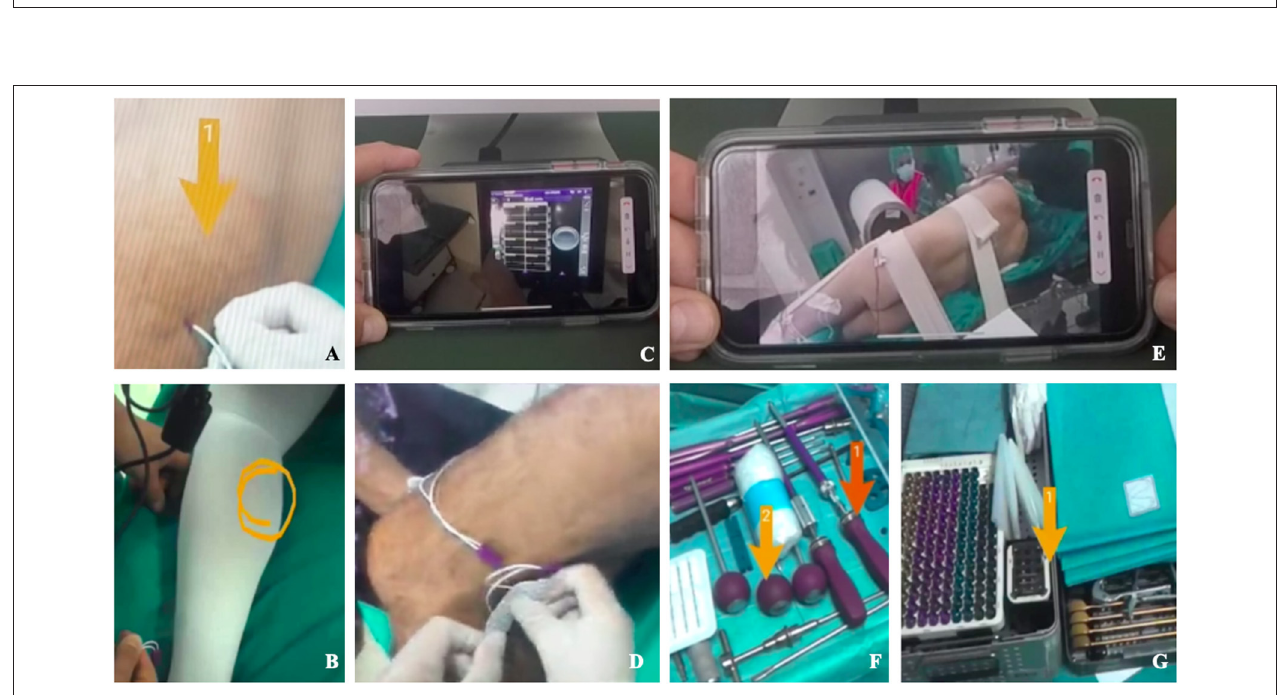
FIGURE 3 | Remote operative Room setup with Epson smart glasses (A–G) . Remote vision of the operative room showing neuromonitoring electrodes positioning (A,B,D) and enhanced videoconference function that allowed to avoid the physical presence of specialists consultants in the OR (A–D) . Remote vision of patient positioning and instrumentation setting in the OR using enhanced videoconference function (E–G) .